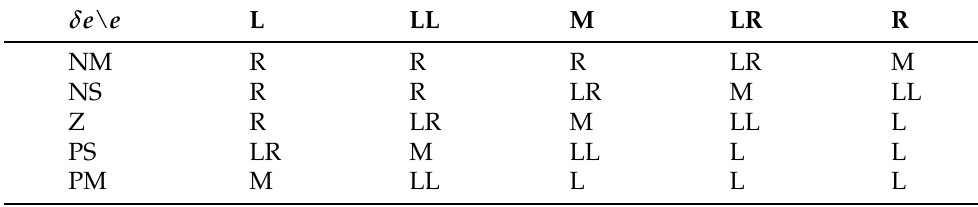
Table 2. Rule base of the fuzzy logic